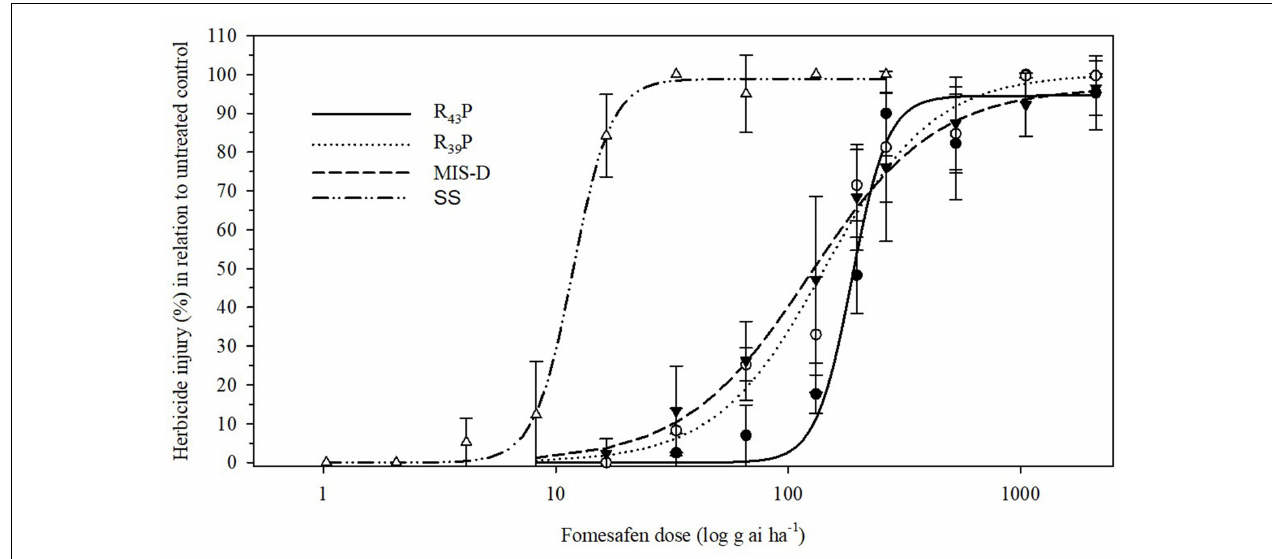
FIGURE 4 | Visible injury (%) of Palmer amaranth SS (wild type), MIS-D (field population), and F1 populations (R 39 P and R 43 P) in response to nine fomesafen doses. Symbols and lines represent actual and predicted herbicide injury responses, respectively. Vertical bars represent + standard errors of the mean. Data were fitted to a non-linear, log-logistic regression function, Y = d/[1+exp{b[log(x) –